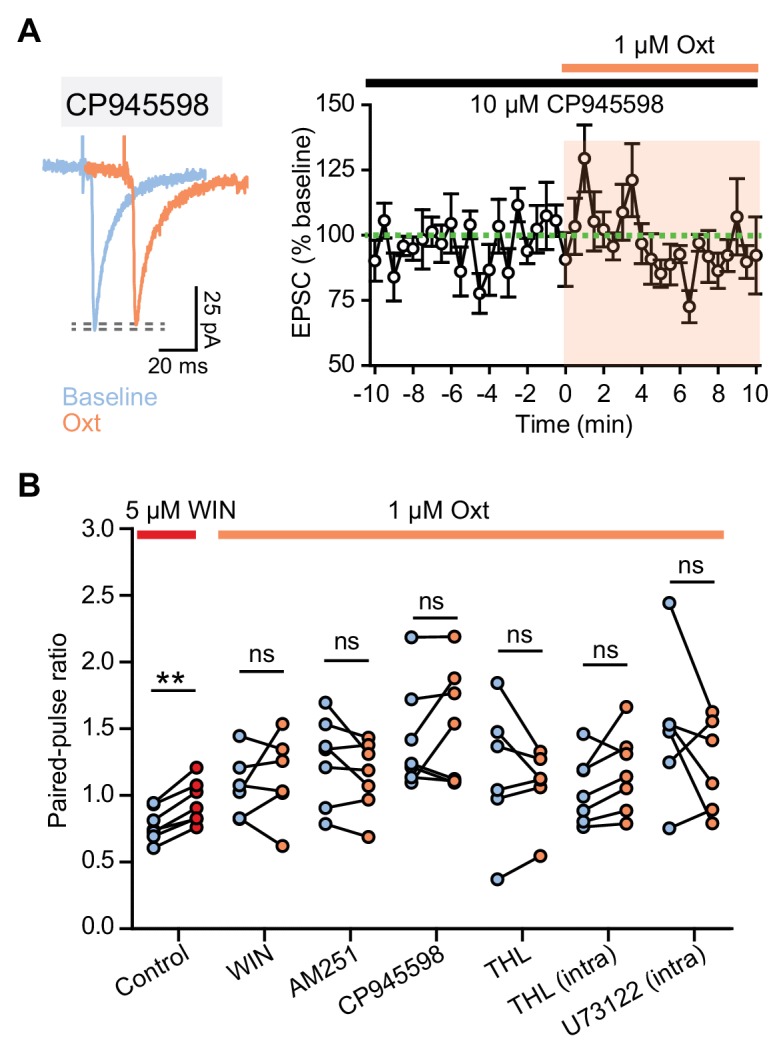
Endocannabinoid signaling underlies oxytocinergic regulation of the amplitude and PPR of evoked EPSCs in VTA DA neurons.(A) Left: example traces of evoked EPSCs from one VTA DA neuron during baseline and following 1 μM oxytocin application in the presence of CB1R antagonist CP945598. Right: summary data for EPSC amplitude over time, normalized to baseline. n = 6 neurons from four mice. (B) Summary results show paired-pulse ratio during baseline and following CB1R agonist WIN55212-2 application and oxytocin application in the presence of WIN55212-2, CB1R inverse agonist AM251, CB1R antagonist CP945598, and orlistat (THL), separately. **p<0.01, Wilcoxon matched-pairs signed rank test. For each condition respectively, n = 7 neurons from five mice, six neurons from four mice, six neurons from three mice, six neurons from four mice, six neurons from four mice, seven neurons from four mice, and six neurons from four mice. Error bars reflect SEM.